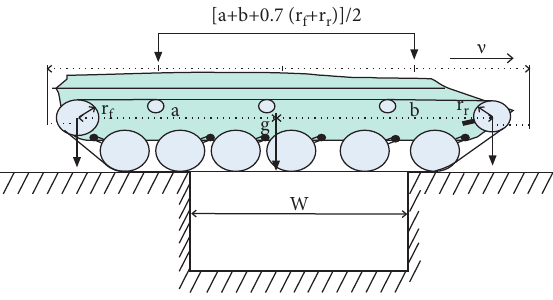
Figure 9: Key parameters of vehicle crossing trench. Table 7: Key parameters of vehicle crossing